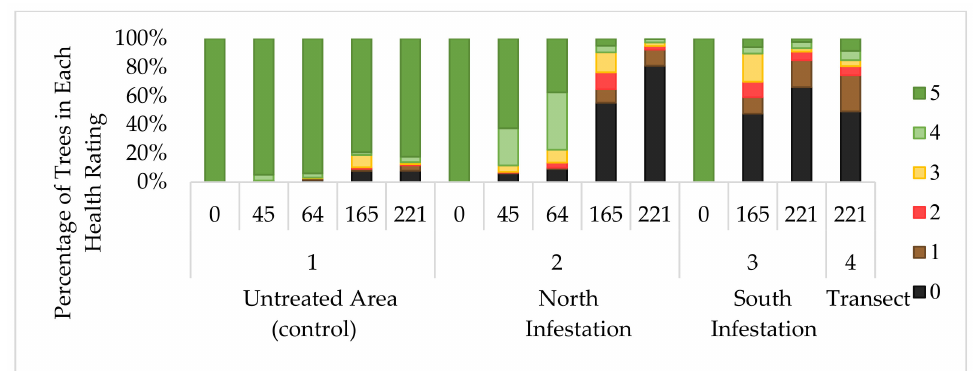
Figure 5. Progress of parkinsonia dieback represented as percentage distribution of each health rating class across control (1), north (2) and south infestations (3) over time (WAT) with comparison to transect (4) assessment. Ratings, 5 = highest health score (>95% alive); 4 (71–95% alive); 3 (51–70% alive); 2 (31–50% alive); 1 (<30% alive); 0 (tree assessed as dead).